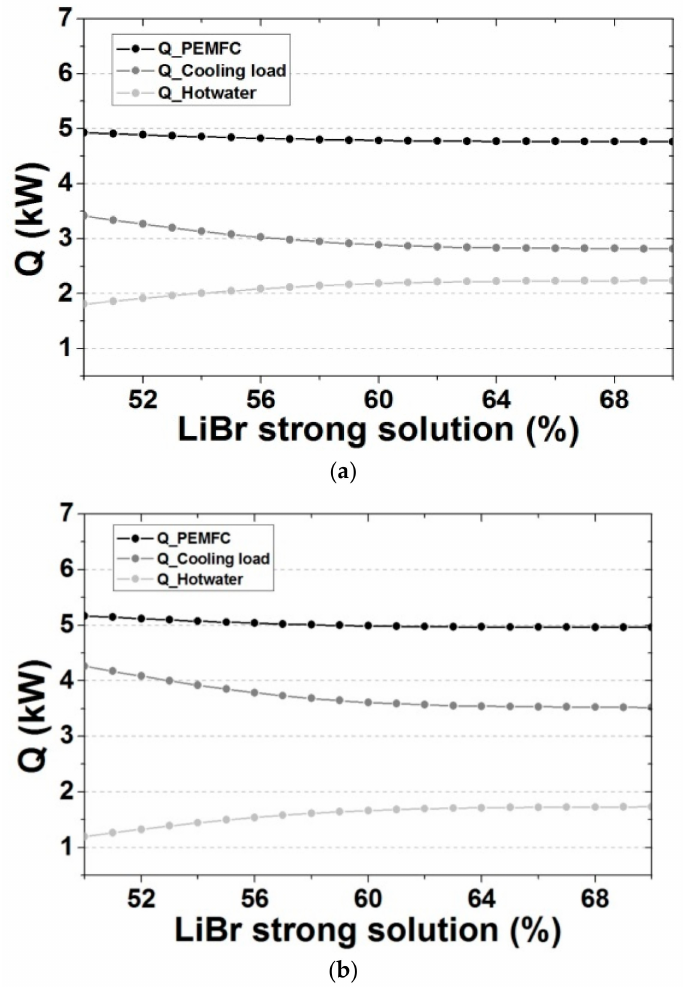
Figure 11. Comparison of stack heating value, cooling and hot water (heating) load according to generator outlet LiBr aqueous solution concentration of absorption cooling system. ( a ) Absorption cooling capacity: 2.0 kW; ( b ) Absorption cooling capacity: 2.5